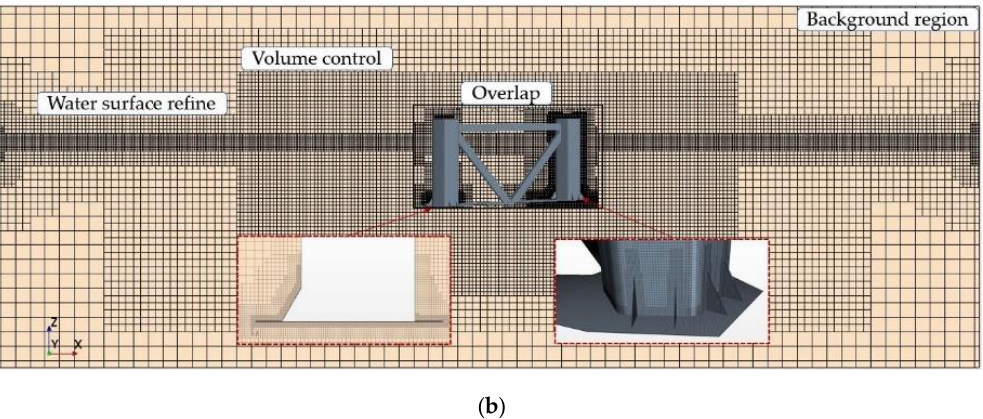
Figure 2. The whole fluid domain: ( a ) Boundary conditions in CFD, ( b ) Mesh distribution in xz-plane and close-up view of mesh around heave plate.